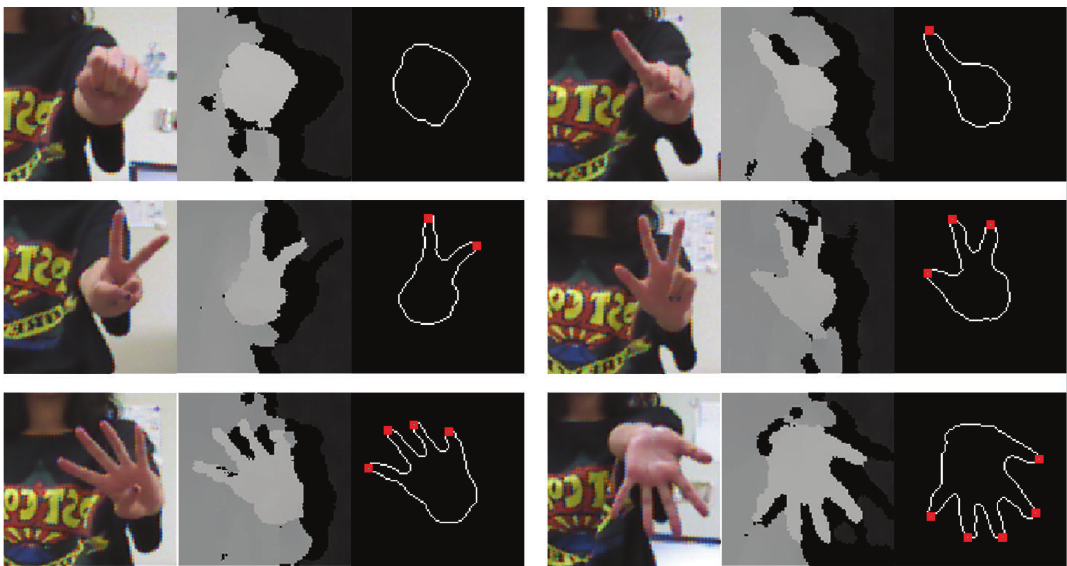
Figure 13: Examples of six different finger gestures used in the second experiment.